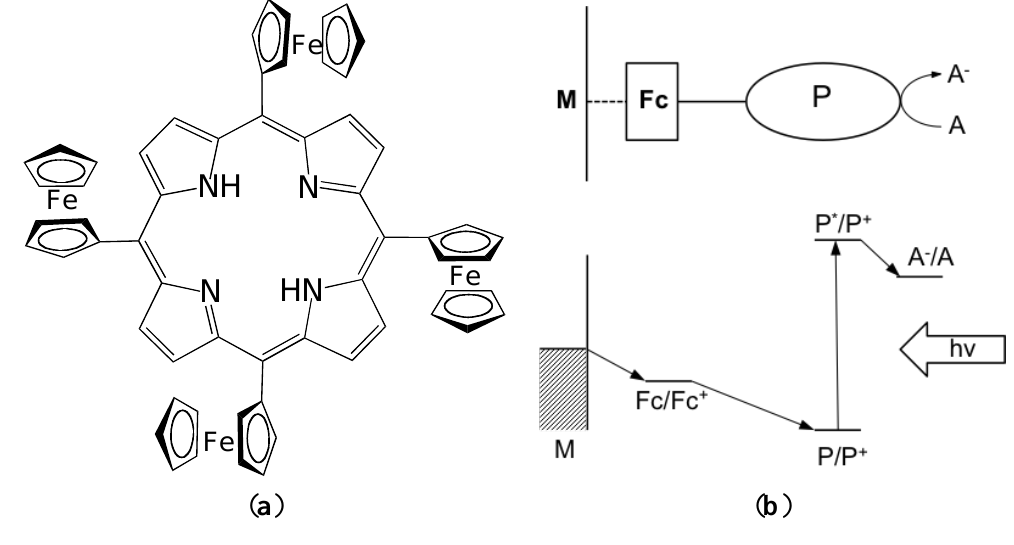
Figure 1. ( a ) Chemical structure of free-base meso-tetraferrocene porphyrin, H ( b ) energy level diagram showing possible photochemical events in porphyrin-ferrocene in contact with a conducting transducer M and solution containing an electron acceptor